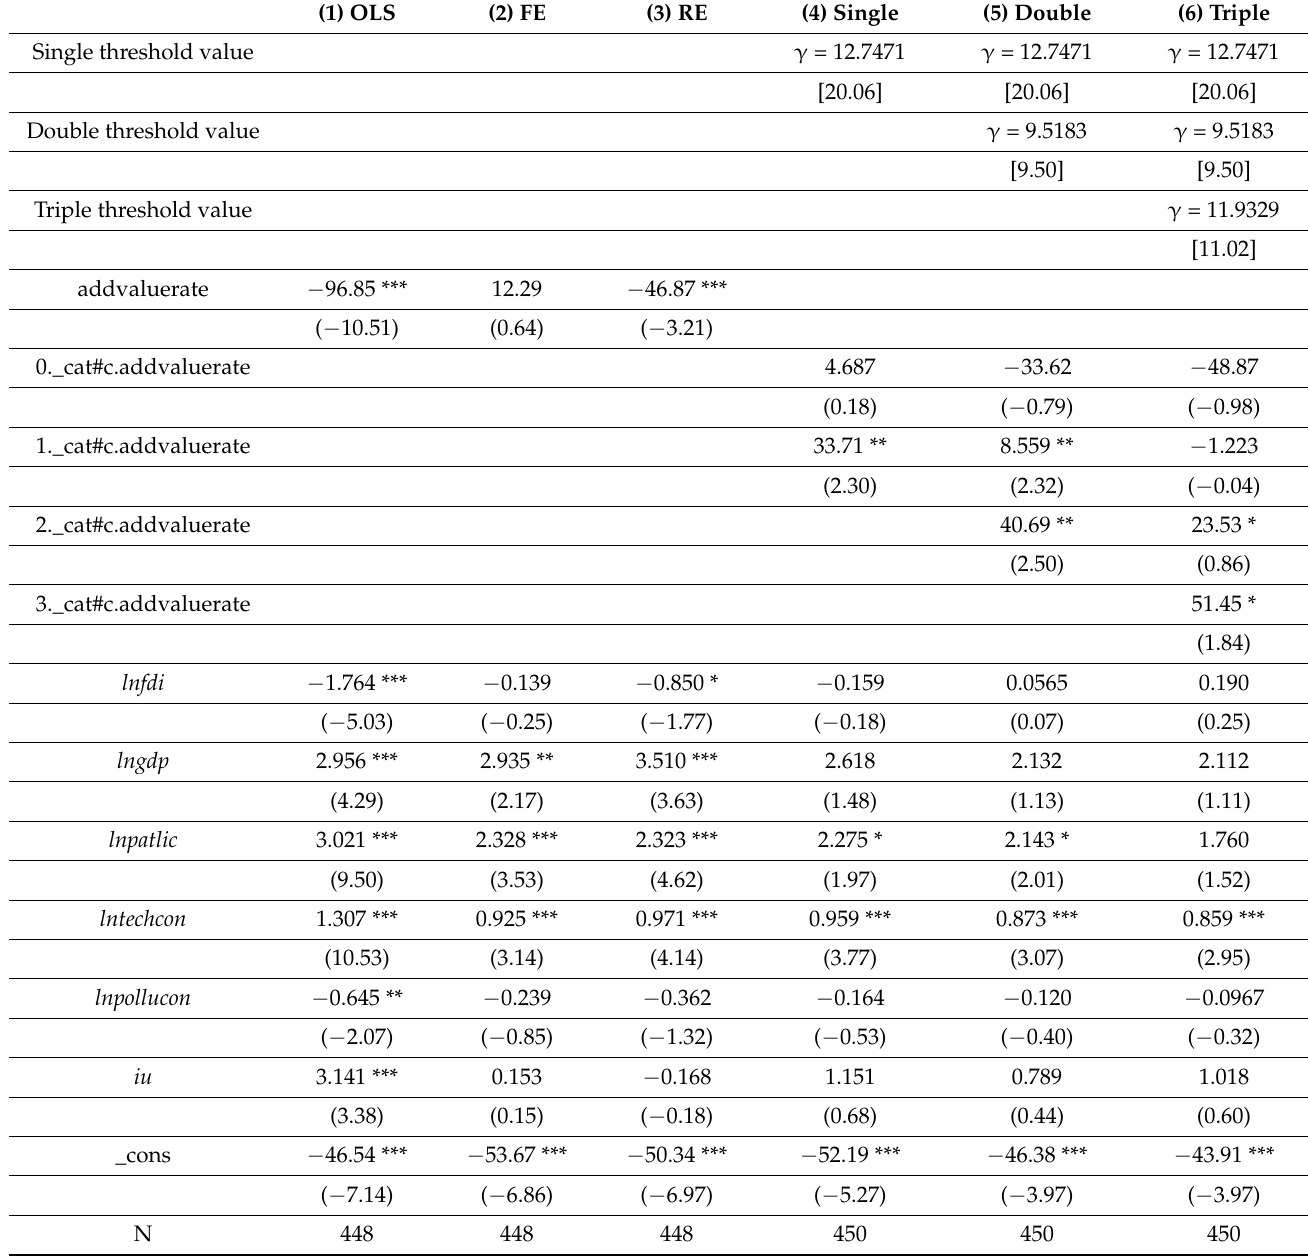
Table 3. Baseline regression results.